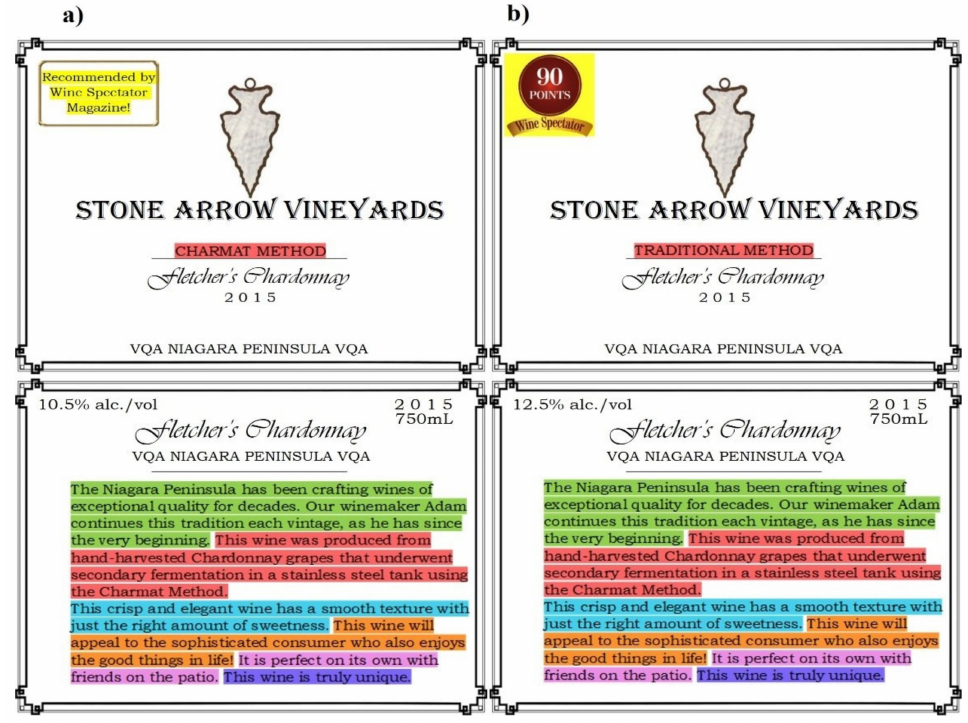
Figure 1. Color coded examples of the control labels used in the study representing different information types. Yellow = endorsements, green = parentage, turquoise = attributes, pink = target end use, orange = target end user, red = manufacture, and blue = nonpareil. Image ( a ) is a Champagne- style, traditional method sparkling wine, whereas ( b ) is a Charmat method-produced sparkling wine. The colors were not presented to the